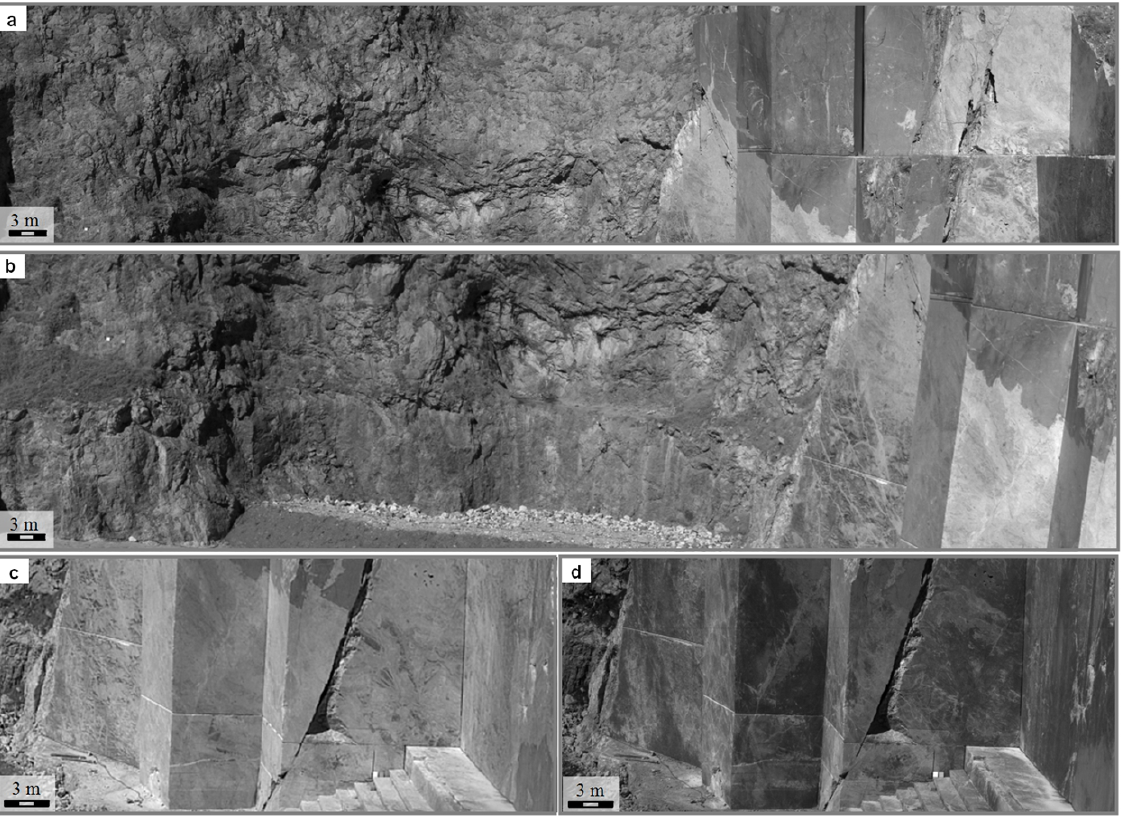
Figure 2. ( a ) Hyperspectral image P-B2, band 1: 1.336 µm; ( b ) Image P-B1, band 1: 1.336 µm; ( c ) Band 62: 1.639 µm and ( d ) band 225: 2.429 µm of image